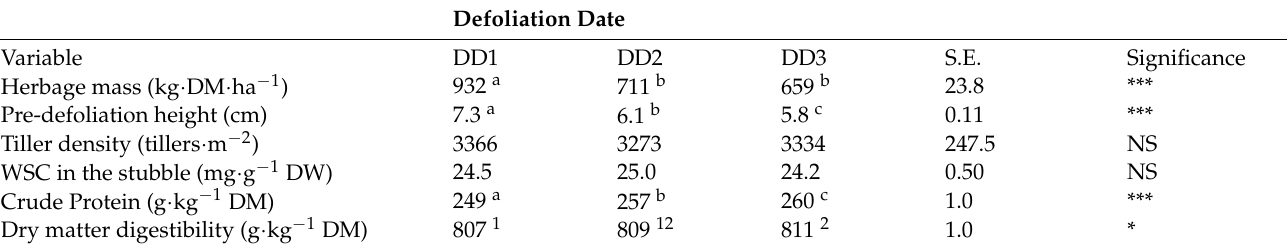
Table 5. Effect of the interaction of target herbage mass (Low—500 kg · DM · ha − 1 , Medium—1500 kg · DM · ha − 1 ,